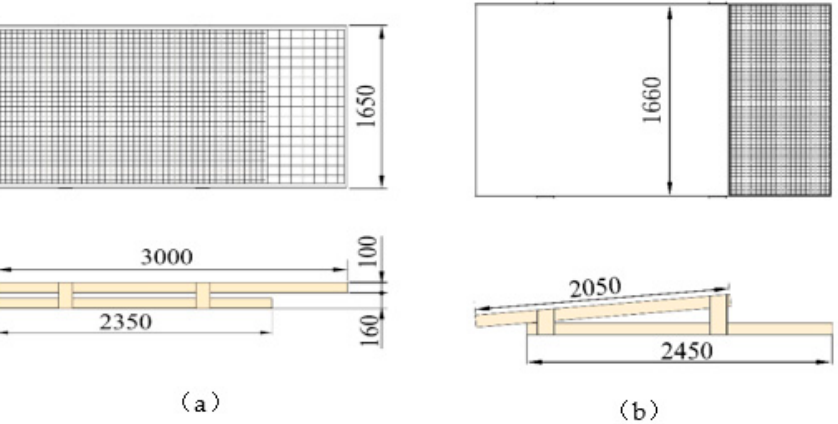
Figure 9. Structure of the vibrating screens. ( a ) Model of the upper sieve; ( b ) Model of the lower sieve.